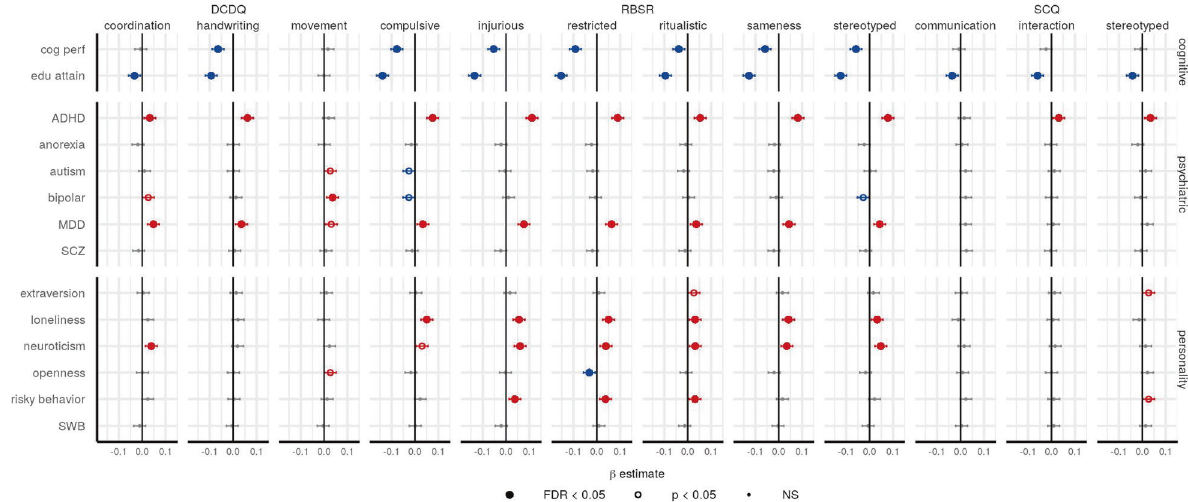
Fig. 5 Main effects of polygenic scores in SPARK. The PGS β estimate from the main effects modeling is plotted with the 95% con fi dence interval. Signi fi cant positive associations are in red, and signi fi cant negative associations are in blue, with a solid circle indicating signi fi cance after multiple testing correction (FDR p < 0.05) and an open circle indicating nominal signi fi cance only. PGS names are cog perf = cognitive performance, edu attain = educational attainment, MDD = major depression disorder, SCZ = schizophrenia, SWB = subjective